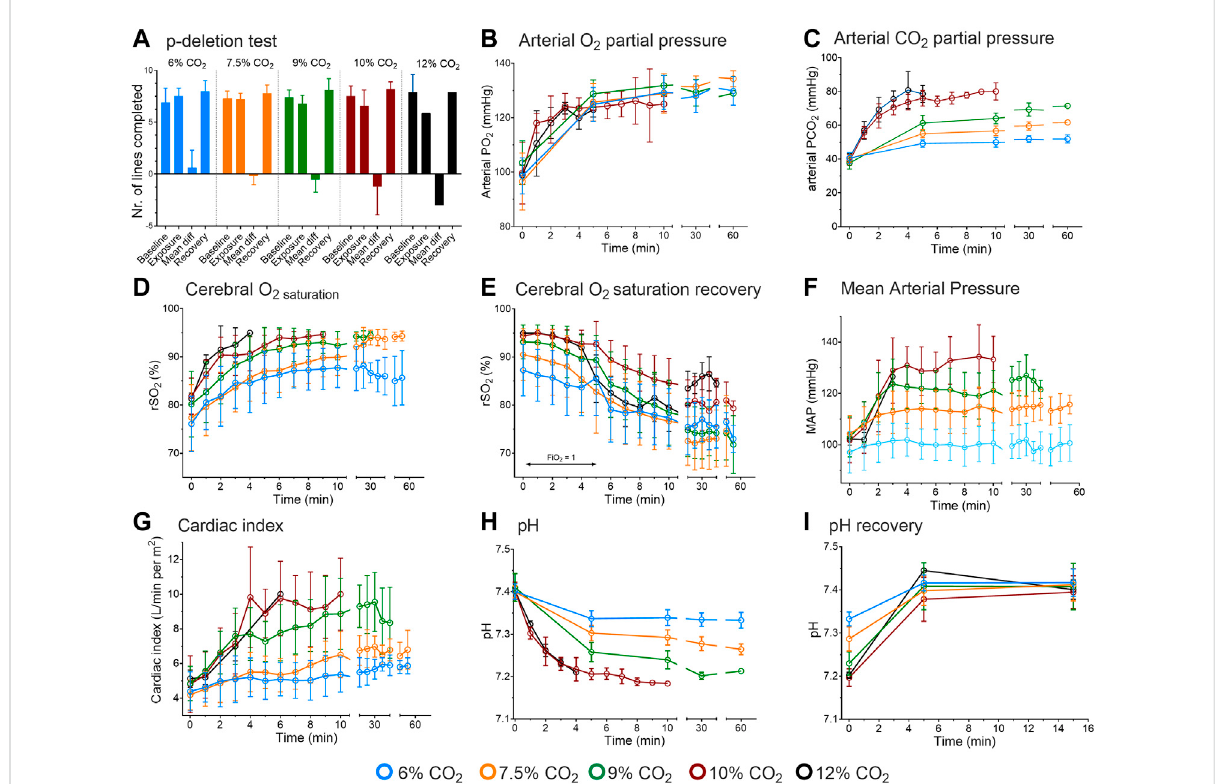
FIGURE 1 Results ofthehumanexperiments. (A) Cognitive functionassessedbyp-deletion test.Results arefrom beforeCO 2 inhalation, during inhalation and during recovery. The mean difference is the difference between tests obtained at baseline and during inhalation. (B) Arterial oxygen concentrations during 6 – 12% CO 2 inhalation. (C) Arterial carbon dioxide concentrations during CO 2 inhalation. (D) Cerebral oxygen concentration asmeasuredbynear-infraredspectroscopyduringCO 2 inhalation. (E) CerebraloxygenconcentrationfollowingCO 2 inhalationwhilebreathing 100%oxygen(for5 min)andnextwhilebreathingroomair. (F) MeanarterialpressureduringCO 2 inhalation. (G) CardiacindexduringCO 2 inhalation. (H) . pH values during 6 – 12% CO 2 inhalation. (I) . pH data obtained during the fi rst 15-min following CO 2 exposure while breathing 100% oxygen. The data obtained at 12% inhalation are from 2 subjects; duration of 10 and 12% CO 2 inhalation was max. 10 min. All data are mean ± SD.